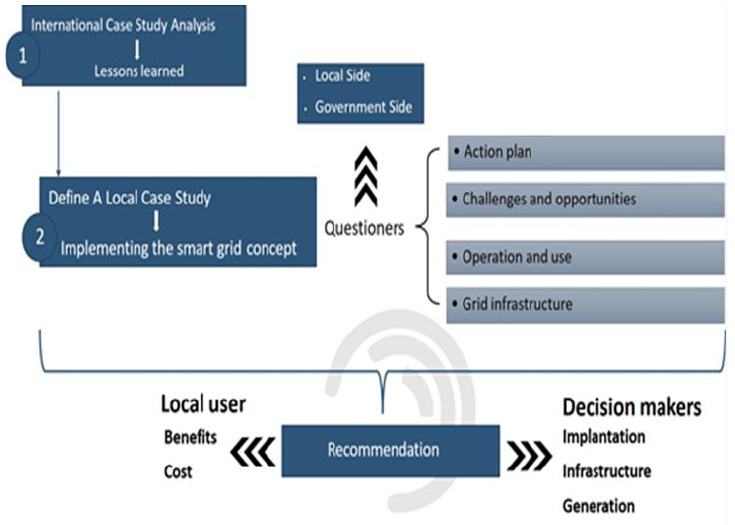
Figure 6. The schematic diagram.